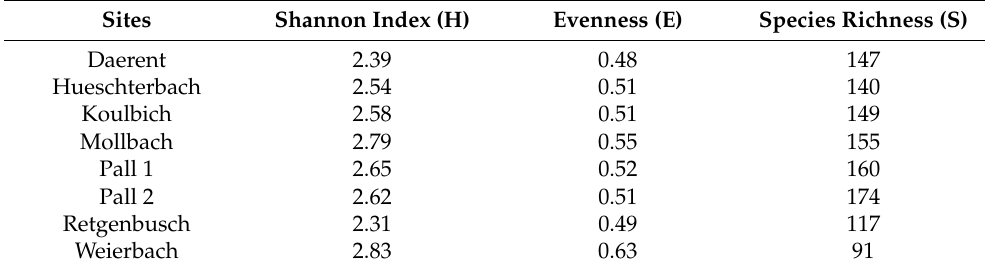
Table 4. Shannon diversity index (H), evenness (E) and richness (S) on genus level of DNA bacterio- phage from the known fraction of the population from the soil of the studied sites.